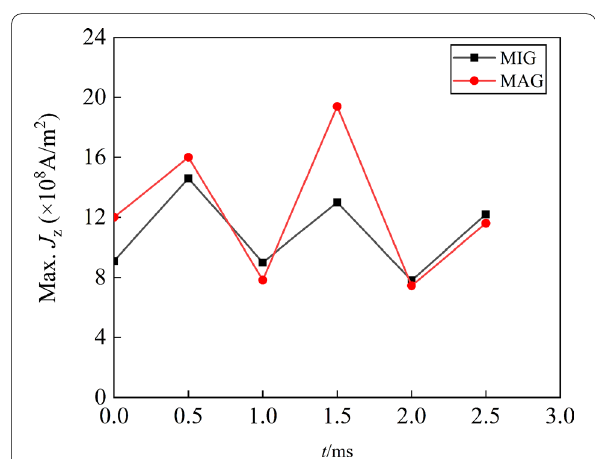
Figure 5 Maximal current density in the z-direction of 500 A MIG and